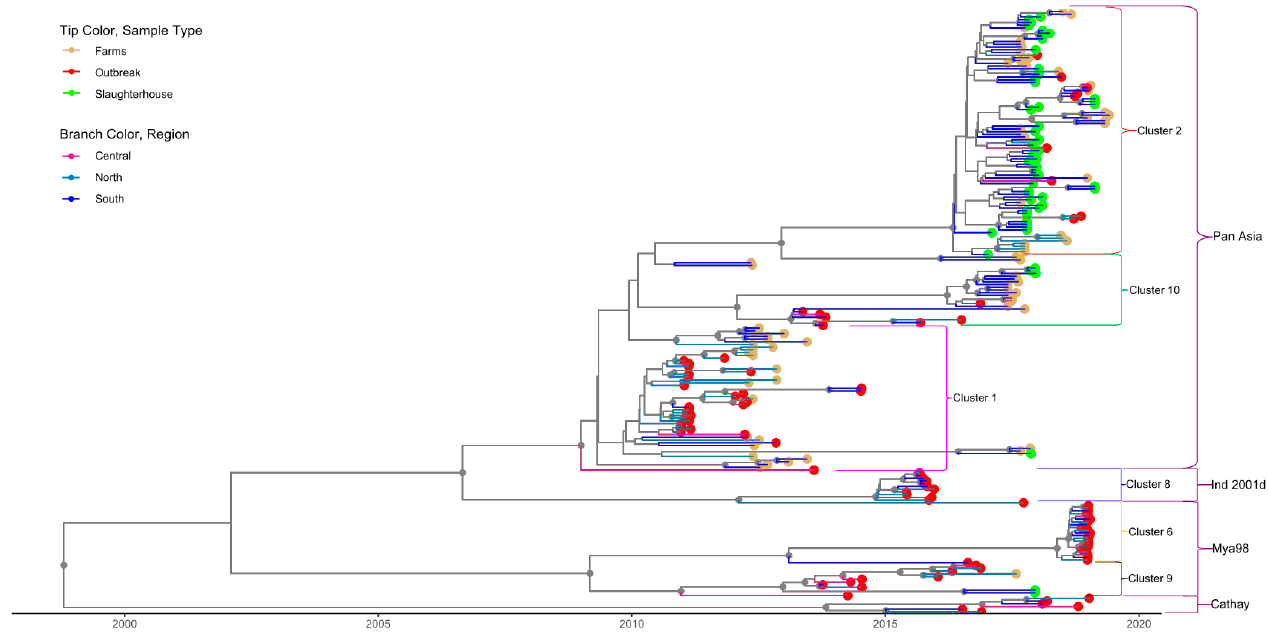
Figure 3. Time-scaled phylogeny for serotype O sequences isolated in Vietnam. Tip color indicates the source type of data (slaughterhouse, farm and outbreak). Different branch colors show the region of the country where sequences were isolated. Small brackets identify the clusters; only clusters with >10 sequences are labelled. The large brackets identify the lineages to which each cluster belongs. Gray circles indicate well-supported clades (posterior probabilities > 0.70).